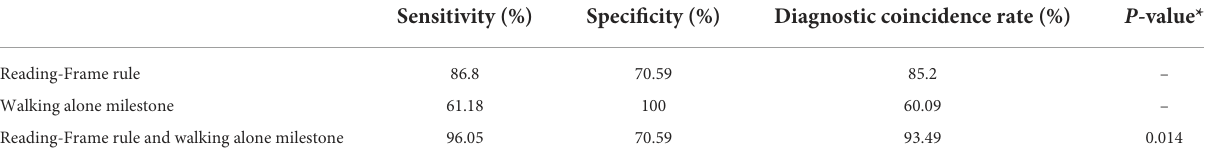
TABLE 3 “Reading-frame rule” and “walking alone milestone” in prediction for